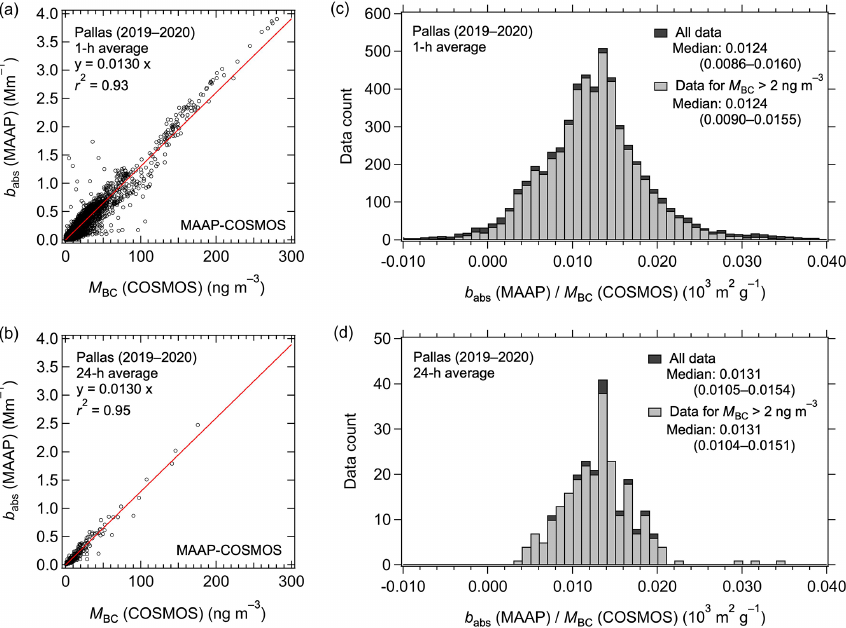
Figure 11. Correlations of M BC (COSMOS) and b abs (MAAP; λ = 637nm) from July 2019 to July 2020 at Pallas for (a) 1h averaged and (b) 24h averaged data. The solid red lines are the least-squares regressions forced through the origin. (c, d) Corresponding histograms of b abs (MAAP) /M BC (COSMOS) ratios for all data and data with M BC (COSMOS) > 2ngm − 3